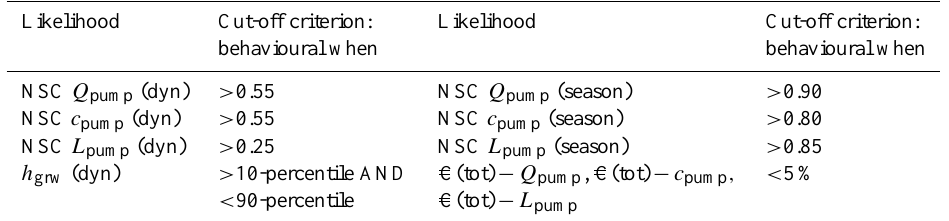
Table 3. “Goodness-of-fit” criteria (likelihoods) and cut-off criteria. Model runs are only assigned as behavioural when they satisfy all the individual goodness-of-fit